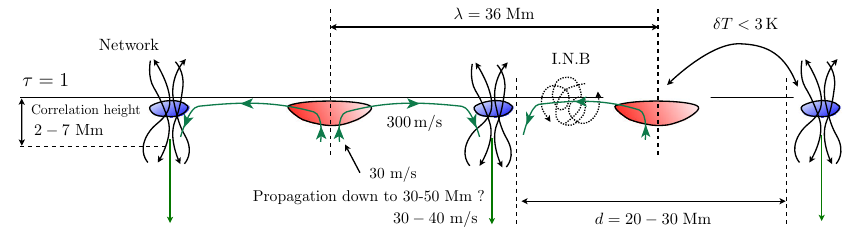
Fig.17 A schematic view of the supergranulation phenomenon as currently constrained by observations. λ is the scale where the horizontal kinetic energy spectral density is maximum. d is the diameter of “coherent structures” (supergranules). The red and blue patches depict the warm and cold regions of the flow. I.N.B denotestheinternetworkmagneticfield(thedichotomybetweennetworkandinternetworkfieldsisprobably not quite as clear as indicated in this drawing). The vertical structure and extent of the dynamics remains one of the main unknowns in this